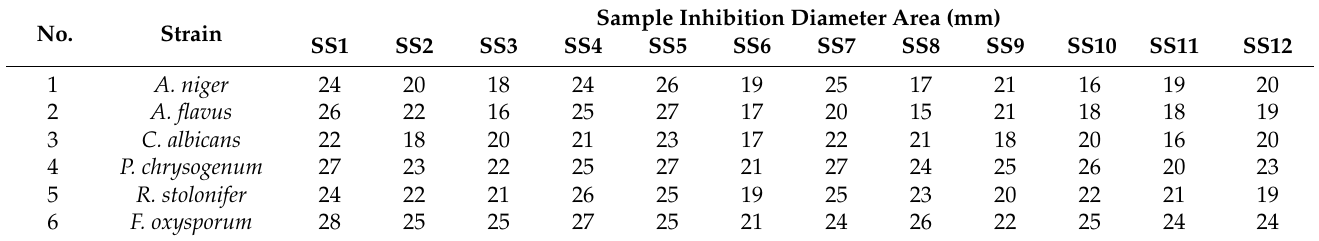
Table 10. Diameters of the inhibition zones on the fungal strains for propolis aqueous extract samples from Alba